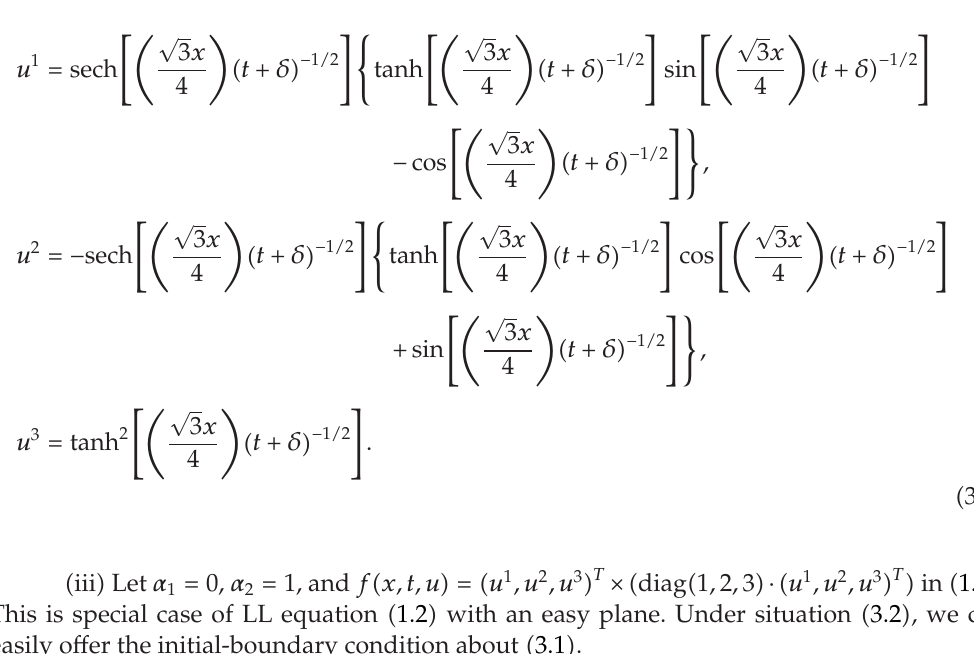
(cid:3) 3.1 (cid:4) still can be used for computation. Figure 4 shows the numerical solution in the t (cid:7) 0 .